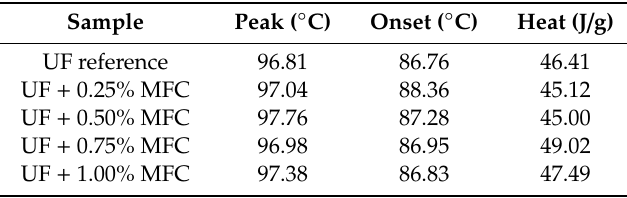
Table 15. DSC analysis results, Experiment 3.1.2 (Approach